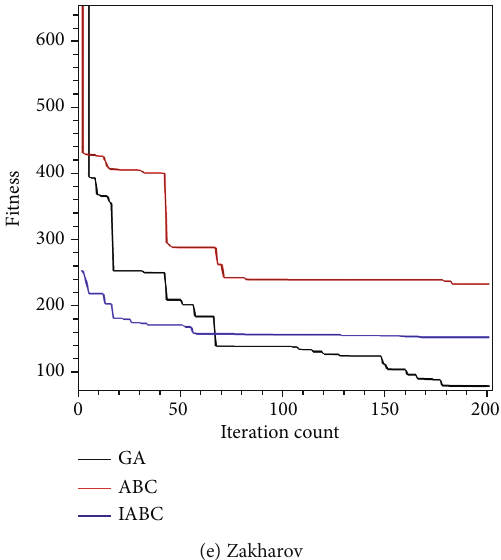
Figure 4: Comparison of the convergence history of the three algorithms based on the 5 benchmark functions.